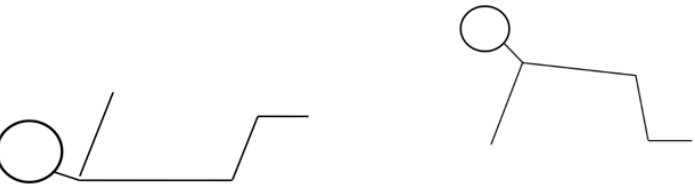
Figure 1. Supine position at the age of 3 months and crawl position at the age of 7 months. Similarities in the spatial positioning of the parts of the body (head, trunk, limbs) can be noticed.